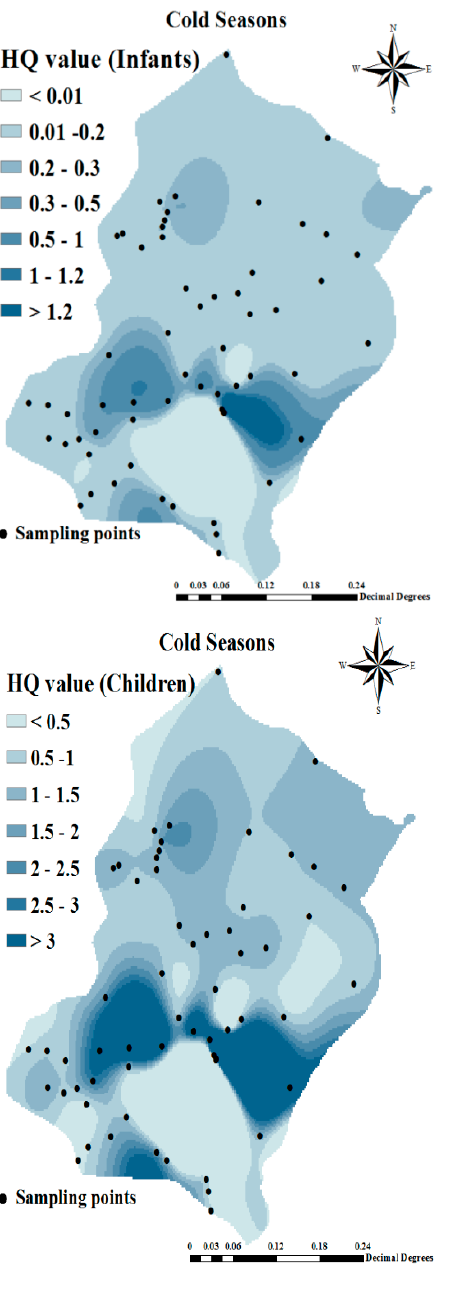
Figure 3. Spatial distribution of hazard quotient (HQ) in cold and warm seasons for infant and children groups.